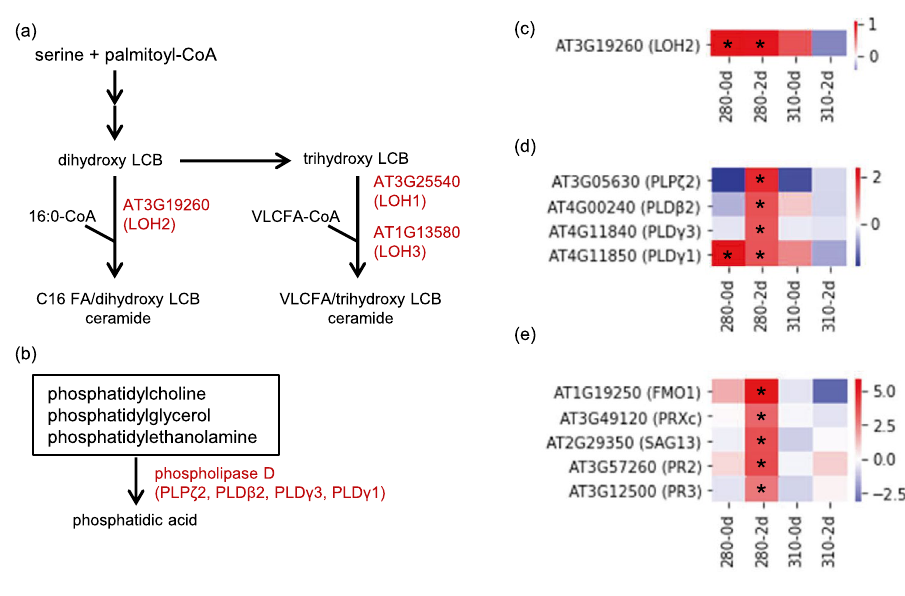
Figure 4. Gene expression profiles of Cer synthase, PLDs, and markers in HR-type PCD under 280 and 310 nm UV-LEDs. ( a ) Metabolic map of Cer biosynthesis. LCB, long-chain base; FA, Fatty acid, VLC, very-long-chain. ( b ) Metabolic map of PE hydrolysis. ( c ) Heat map showing the expression level of LOH2 . ( d ) Heat map showing the expression level of the PLDs . ( e ) Heat map showing the expression level of HR-type PCD marker genes. Changes in gene expression levels relative to the control are expressed as log 2 (fold change) values. As shown on the color scale, blue indicates down-regulation and red indicates up-regulation. Asterisks indicate significant differences between the control and UV-LED irradiation using Welch’s t -test ( P < 0.05).